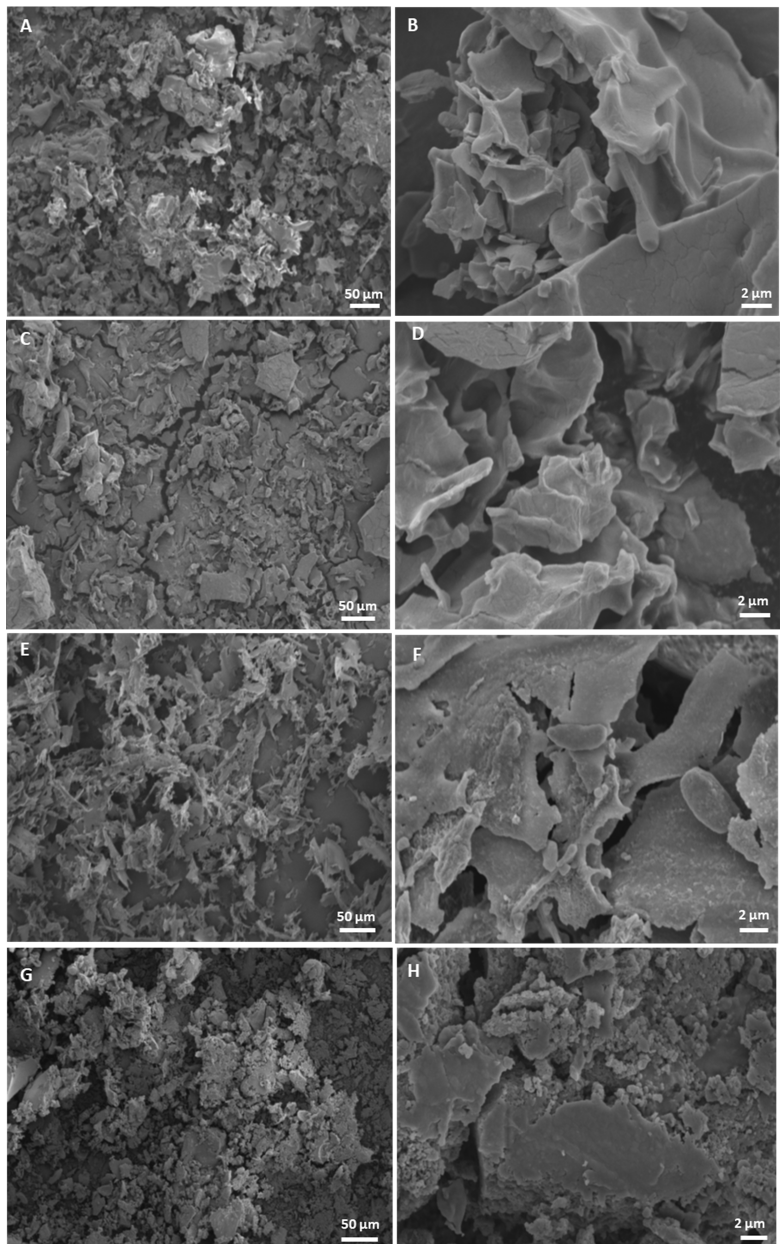
Figure 3. Scanning electron microscopy (SEM) images of polysaccharide fractions isolated from Ajwa flesh and seed: FAP-HWE ( A , B ), FAP-US ( C , D ), SAP-HWE ( E , F ) and SAP-US ( G , H ).